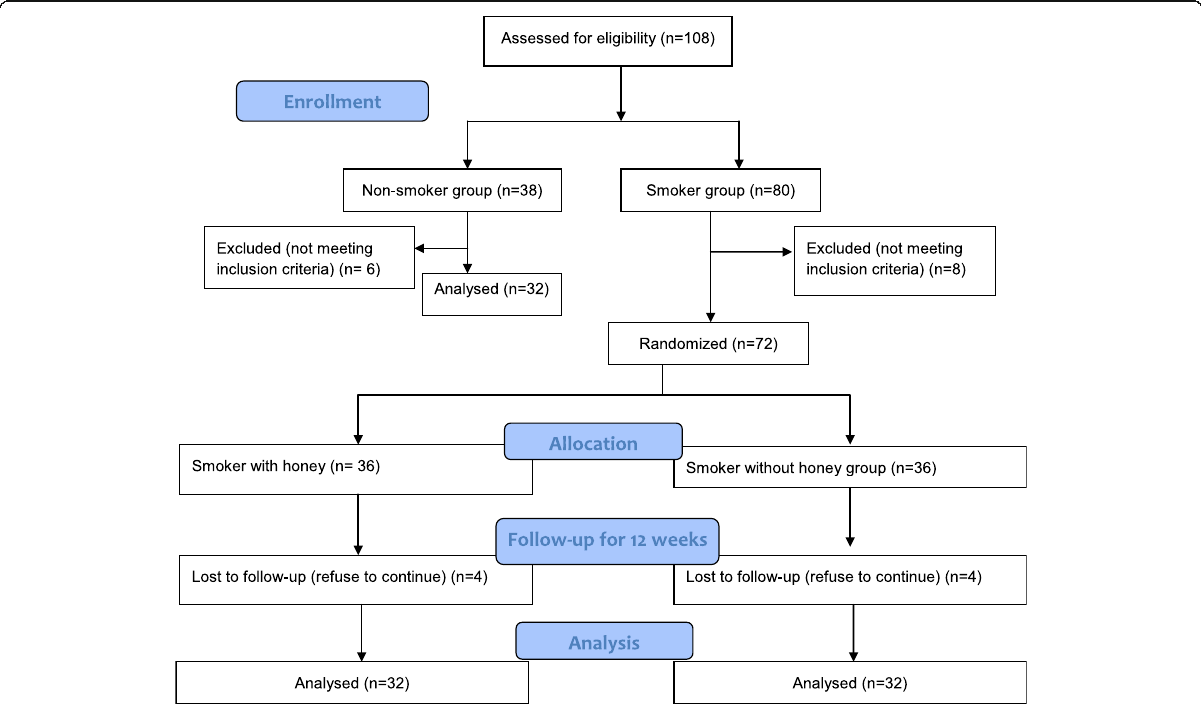
Fig. 1 CONSORT Flow diagram of subject recruitment